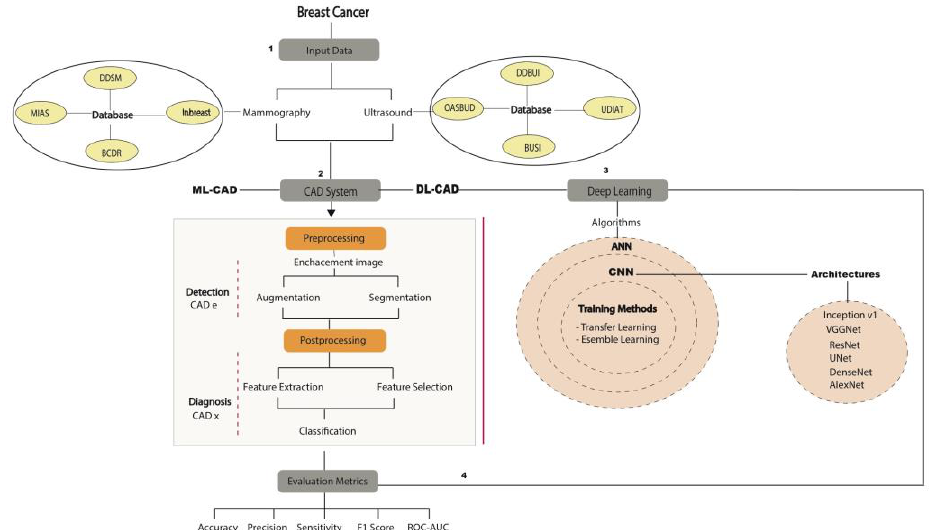
Figure 4. The general diagram is a flowchart that describes how a modern CAD system process can be used with DM and US images from public and private databases. Normally, the CAD system consists of several stages, such as segmentation, feature extraction/selection, and